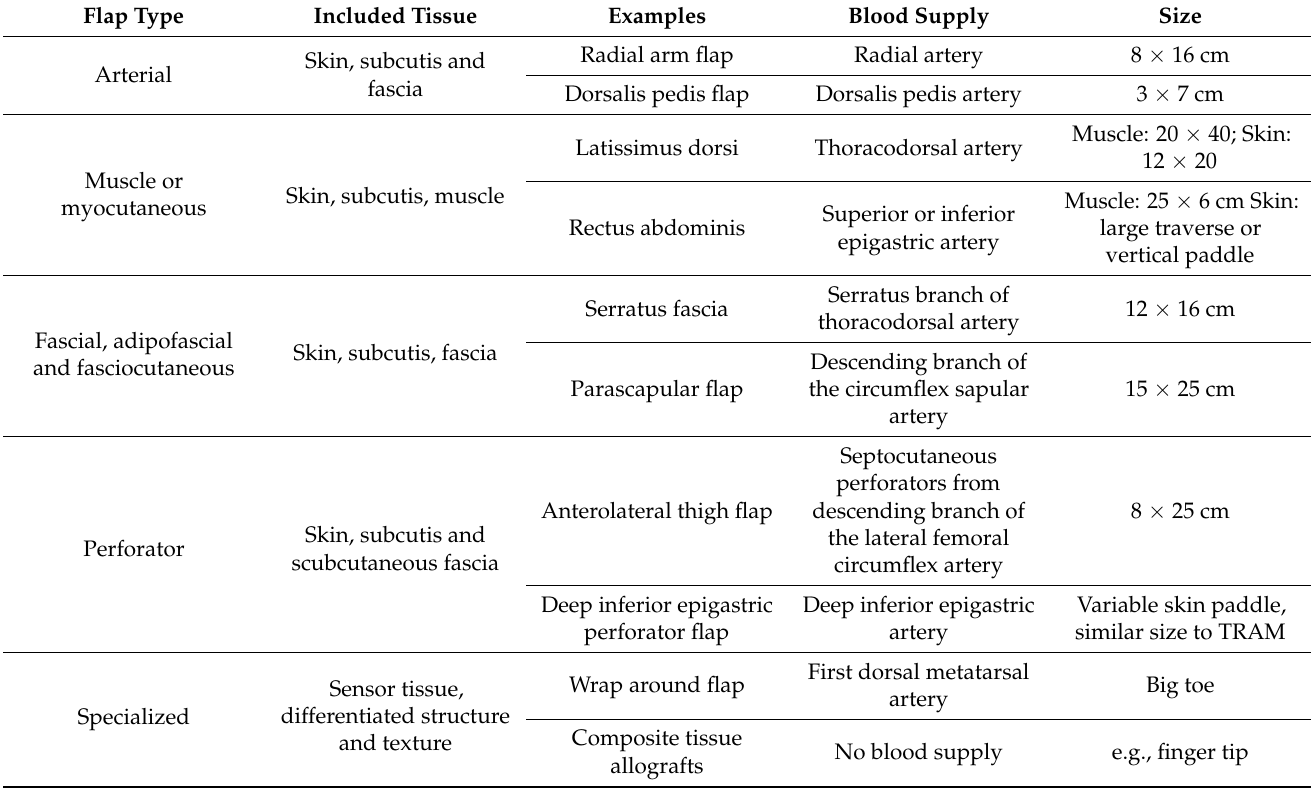
Figure 7. ( A ) Scar after skin graft transplantation, ( B ) 7 days postoperatively after pedicled latissimus dorsi muscle flap transfer, ( C ) Postoperative outcome after one year. Table 1. Free flaps regarding tissue requirements after scar